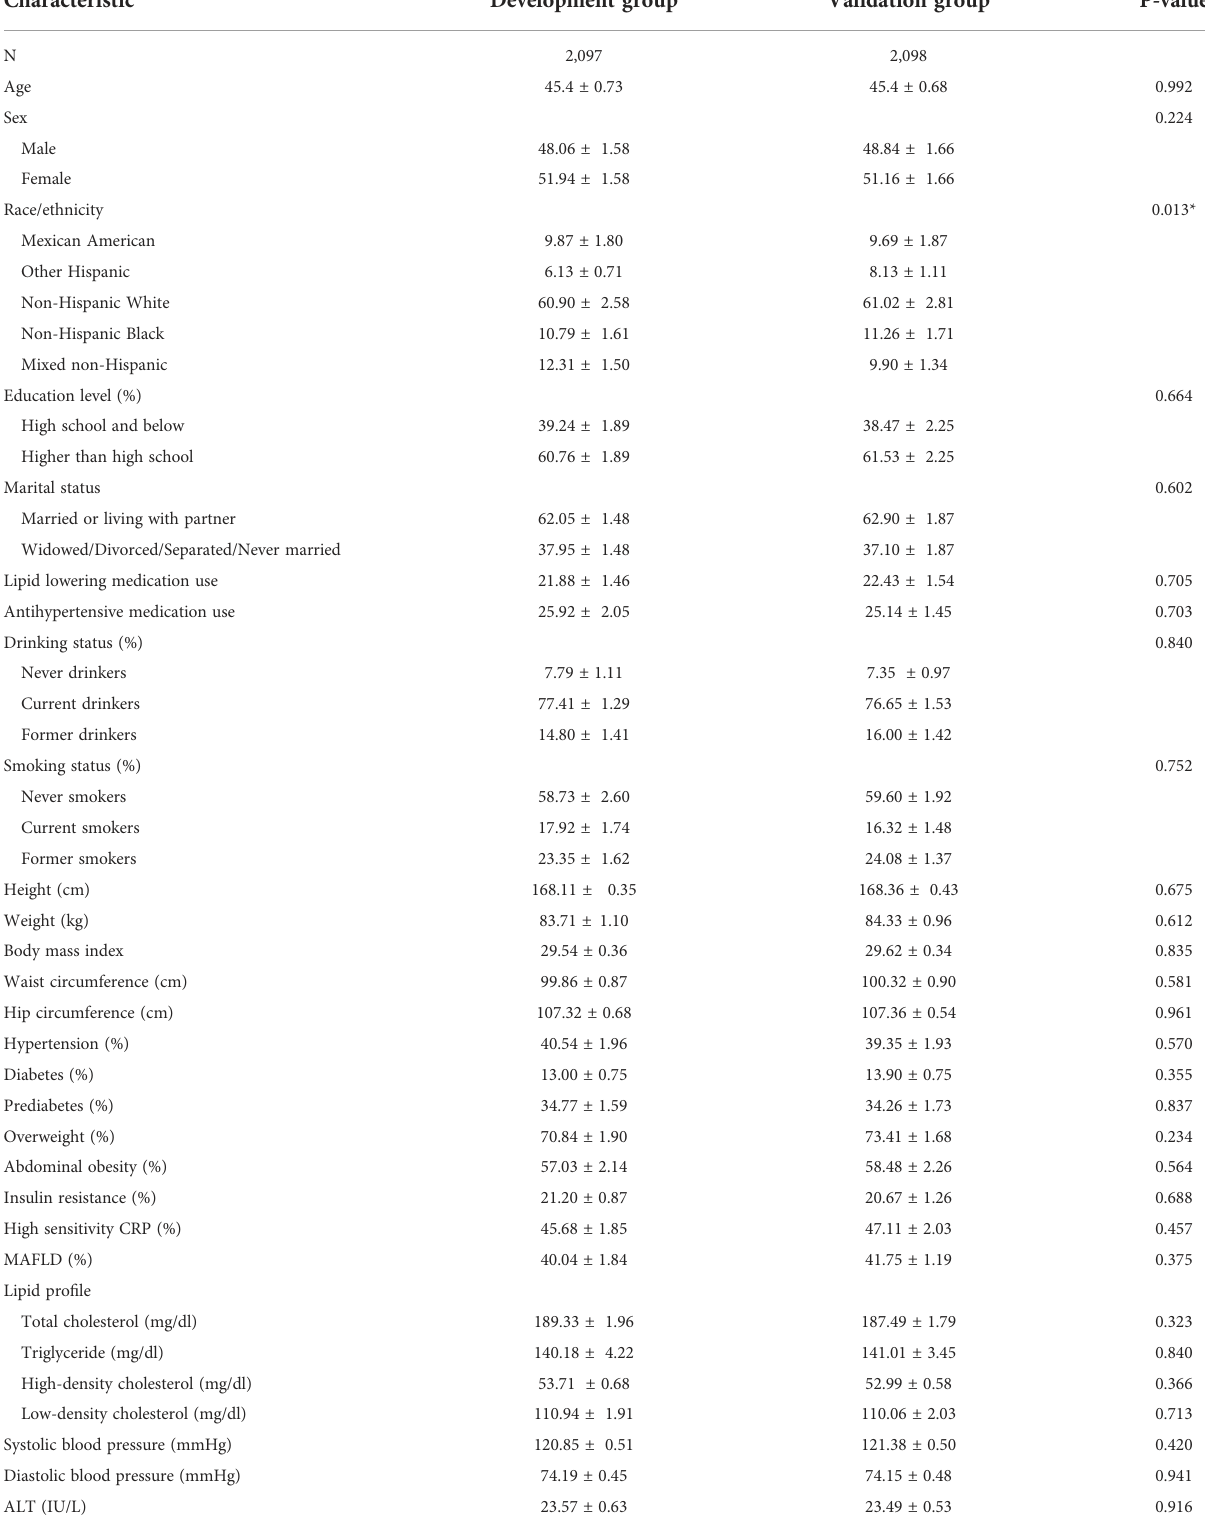
TABLE 6 Baseline characteristics of the development and validation